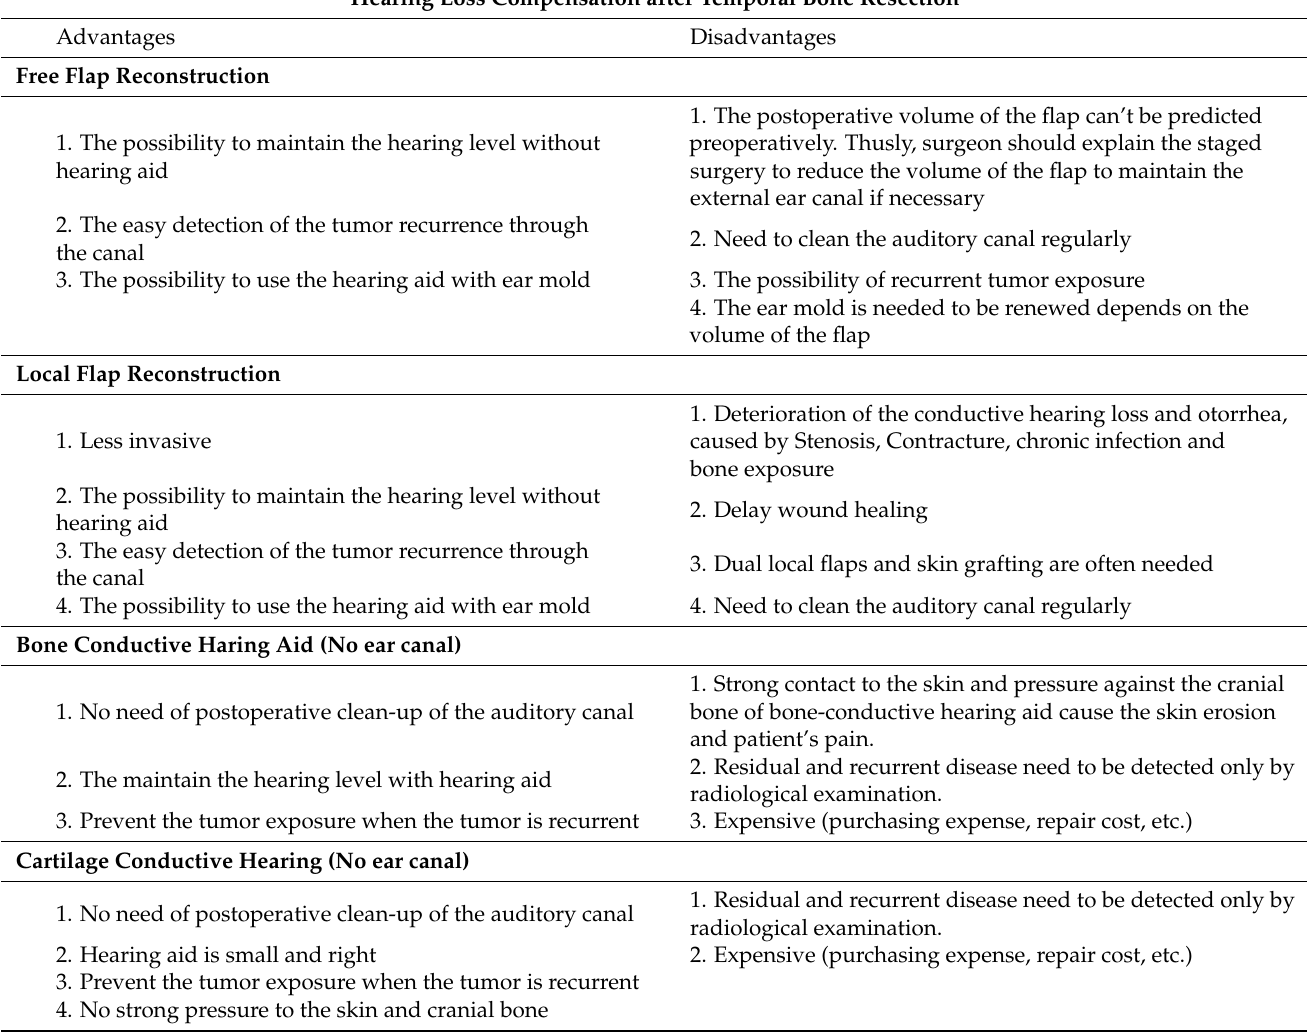
Table 2. Hearing compensation after temporal bone